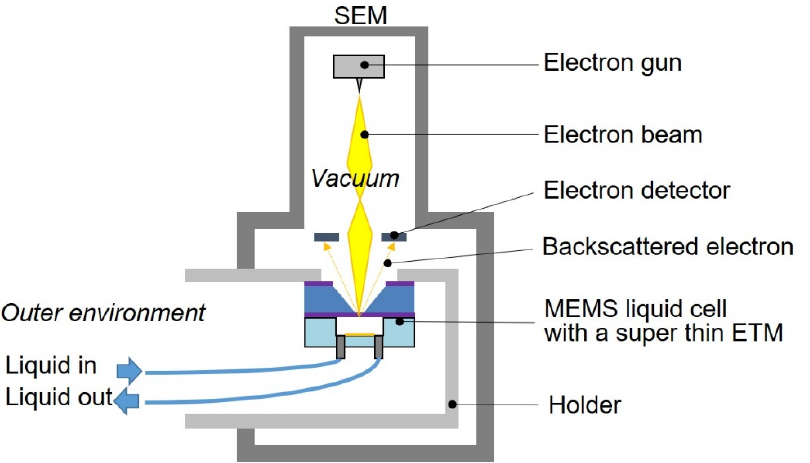
Figure 5. Experimental setup of the microfluidic liquid cell with a super-thin ETM in SEM. When only a super-thin ETM without a microchannel was used for the characteriza- tion, the suspension containing gold nanoparticles or T4 bacteriophages was dropped and